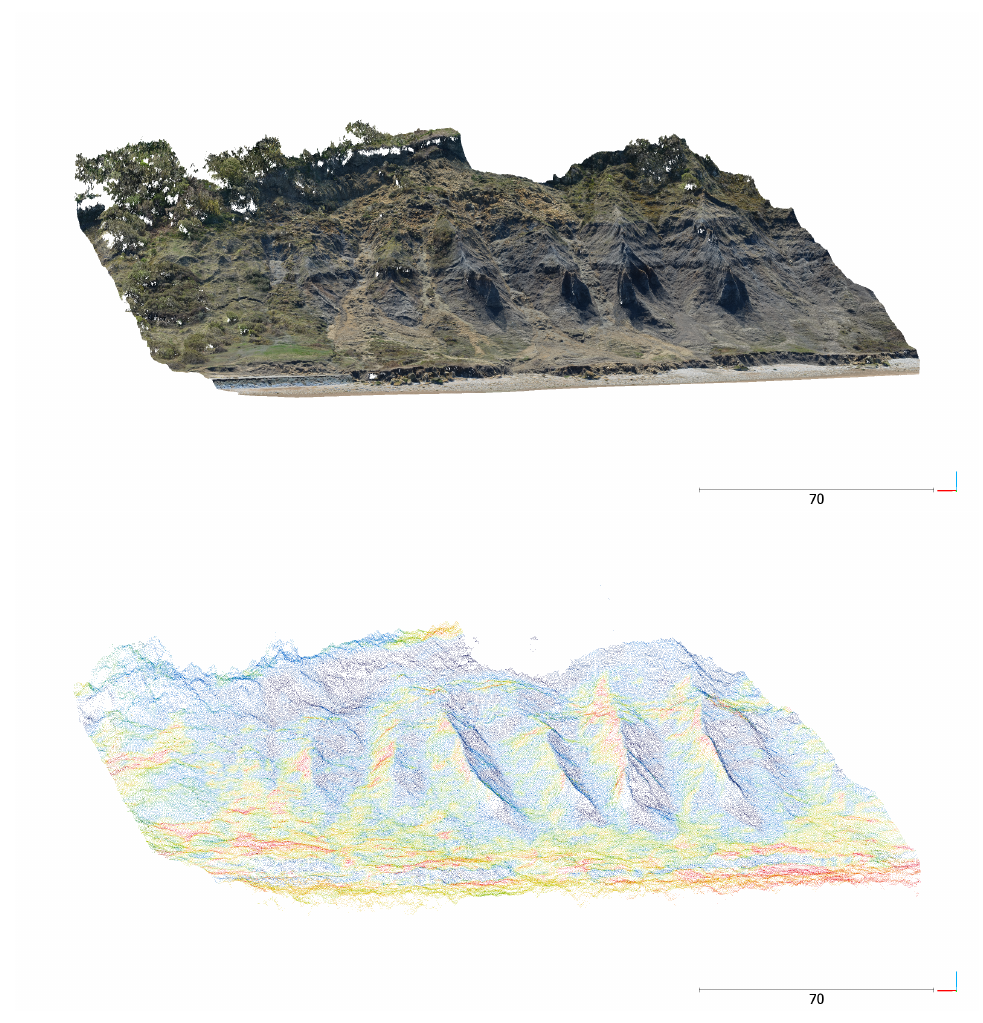
Figure 6. 3D models in the visible and TIR